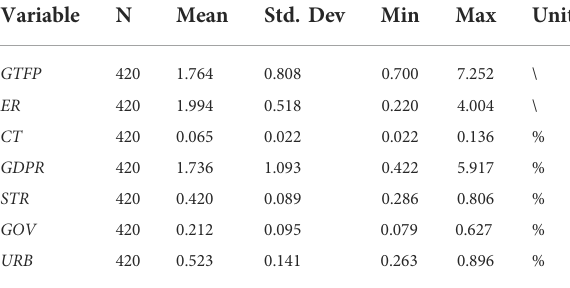
TABLE 1 Descriptive statistics of